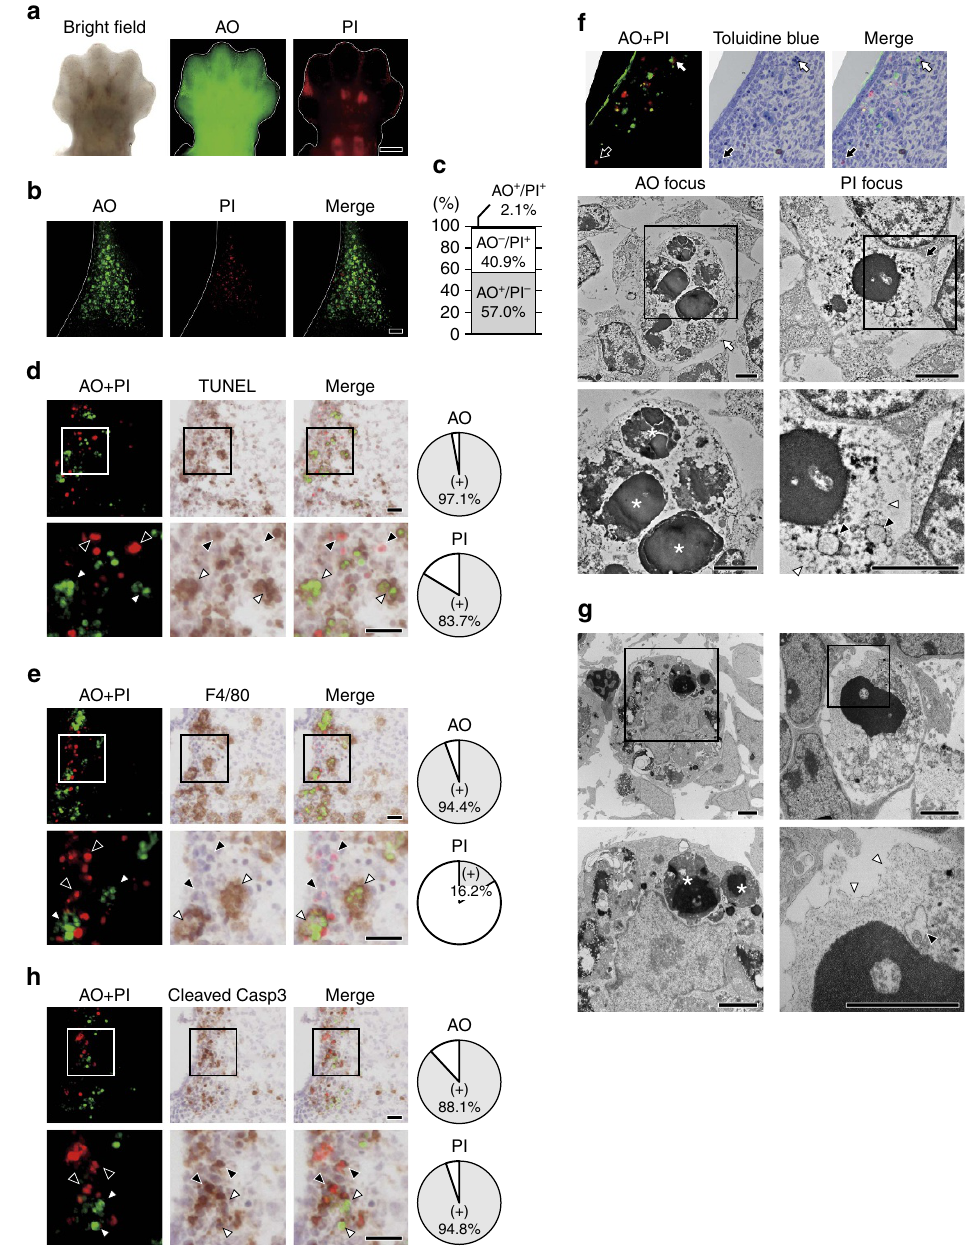
Figure 1 | Vital staining of dead cells with AO and PI. ( a ) AO and PI foci in limb buds. The right forelimb bud of an E13.5 embryo injected with AO and PI were visualized by fluorescence stereomicroscopy. Scale bar, 400 m m. ( b ) The first interdigital region of the forelimb bud of an E13.5 embryo injected with AO and PI was observed by laser scanning confocal microscopy, and maximum intensity projection images were constructed. Scale bar, 50 m m. ( c ) Most of the PI foci and AO foci did not overlap. AO and PI foci in the first interdigital region of the forelimb bud of an E13.5 embryo were separated from background signals by the threshold algorithm ‘Intermodes’ 31 and were counted in 15 tissue sections. ( d ) A high proportion of the AO-positive cells and PI-positive cells were also TUNEL-positive. Axial cryosections of the first interdigital region of the forelimb bud from an E13.5 embryo injected with AO and PI were subjected to TUNEL staining. White arrowheads and black arrowheads indicate AO and PI foci, respectively. The pie chart shows the TUNEL-positive rates of AO foci and PI foci. Scale bar, 20 m m. ( e ) The majority of AO-positive cells, but not PI-positive cells, were engulfed by macrophages. Cryosections of the first interdigital region of the forelimb bud from an E13.5 embryo were subjected to immunostaining with an anti-F4/80 antibody. ( f ) AO-positive cells showed evidence of phagocytosis, while PI-positive cells showed necrotic changes. TEM examination of an AO-positive cell (white arrow) and a PI-positive cell (black arrow). * apoptotic cell or apoptotic body, black arrowhead: swollen organelle, white arrowhead: ruptured plasma membrane. Scale bar, 2.5 m m. ( g ) Dead cells with similar morphologic features to AO-positive cells and PI-positive cells were also observed without vital staining. After euthanasia, an E13.5 embryo without AO or PI injection was rapidly fixed and examined by TEM. ( h ) The majority of AO-positive cells and PI-positive cells were also positive for cleaved caspase-3. Cryosections of the first interdigital region of the forelimb bud from an E13.5 embryo were subjected to immunostaining with an anti-cleaved caspase-3